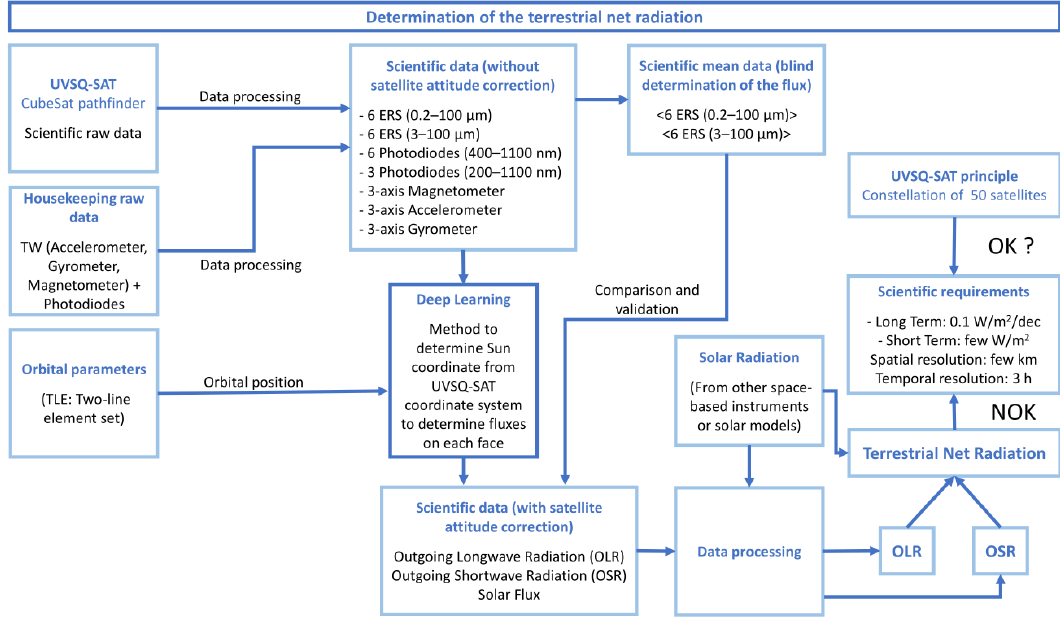
Figure 1. General method to determine the terrestrial net radiation from UVSQ-SAT remote